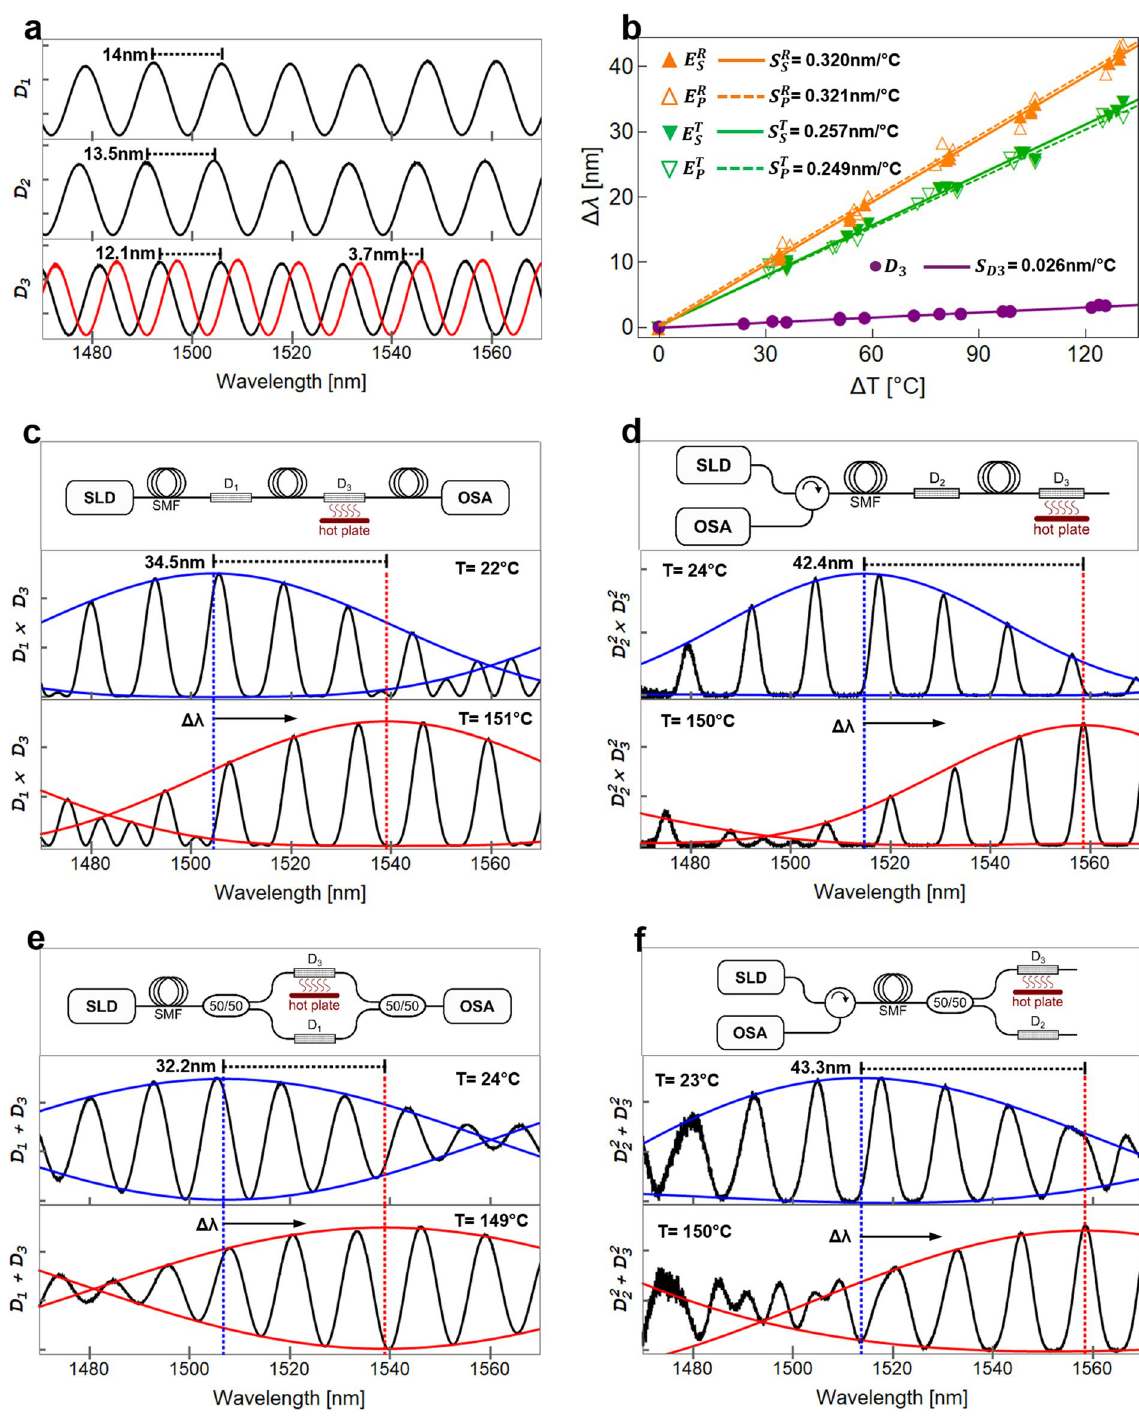
Figure 3. ( a ) Experimental spectral response at room temperature (26 °C) of SCFs with different lengths (solid black lines) and spectral response of device D 3 at 150 °C (solid red line), ( b ) Experimental spectral shift as a function of the applied temperature for device D 3 and also for the different Vernier configurations, ( c )–( f ) Vernier configurations and their experimental spectral responses at room temperature (26 °C) and heated at 150